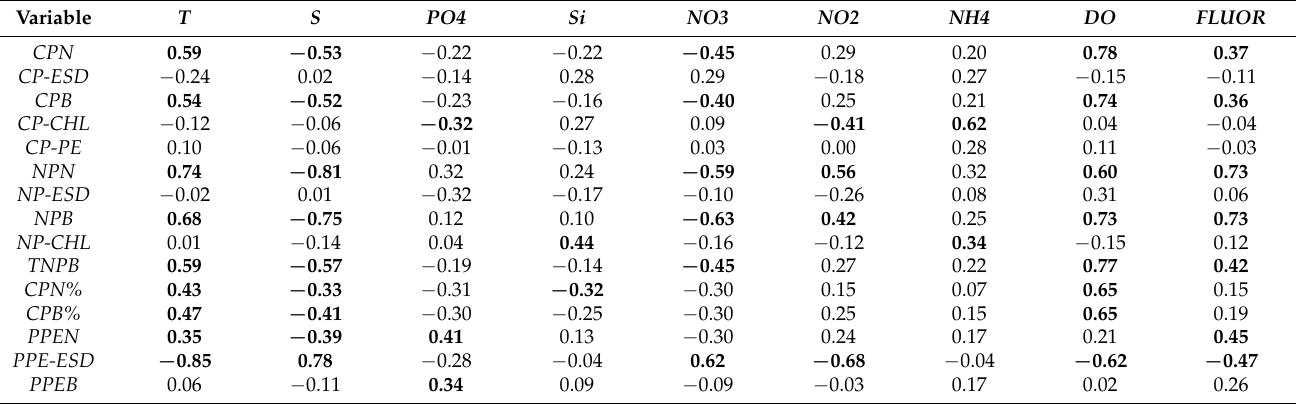
Table 2. Spearman’s correlation between the studied variables. Statistically significant ( p < 0.05) indicators are in bold. The description of the variables is in Table